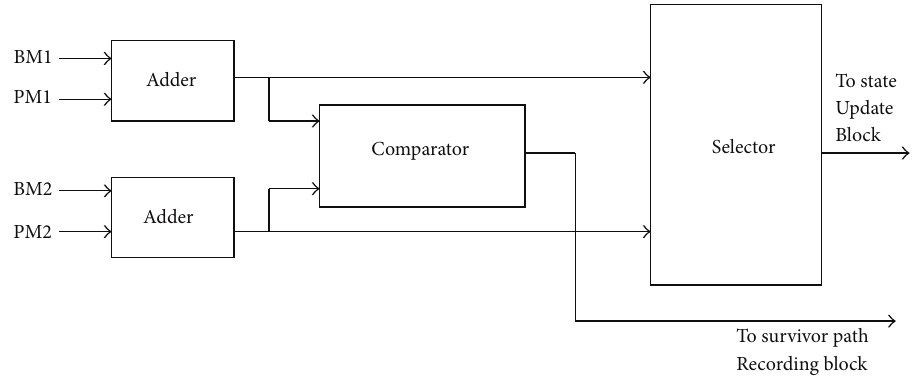
Figure 3: Block diagram of ACS